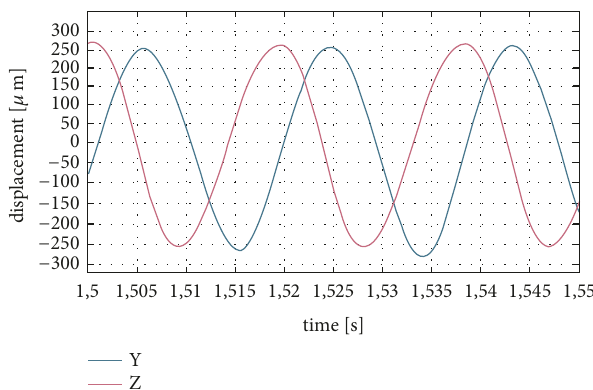
Figure 21: Time zoom of the predicted rotor vertical (in blue) and horizontal (in red) displacements during a radial landing test (DE node).